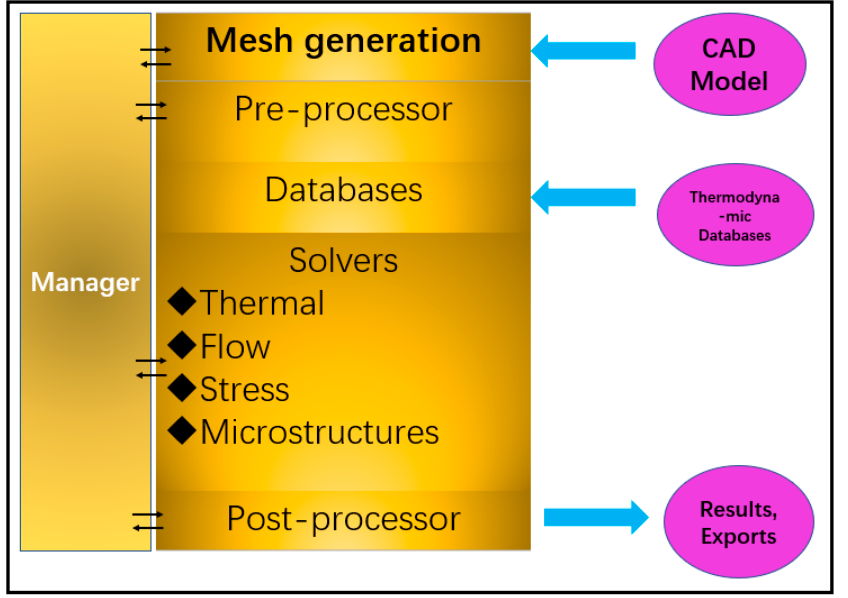
Figure 3. Structure of macro-model ProCAST.